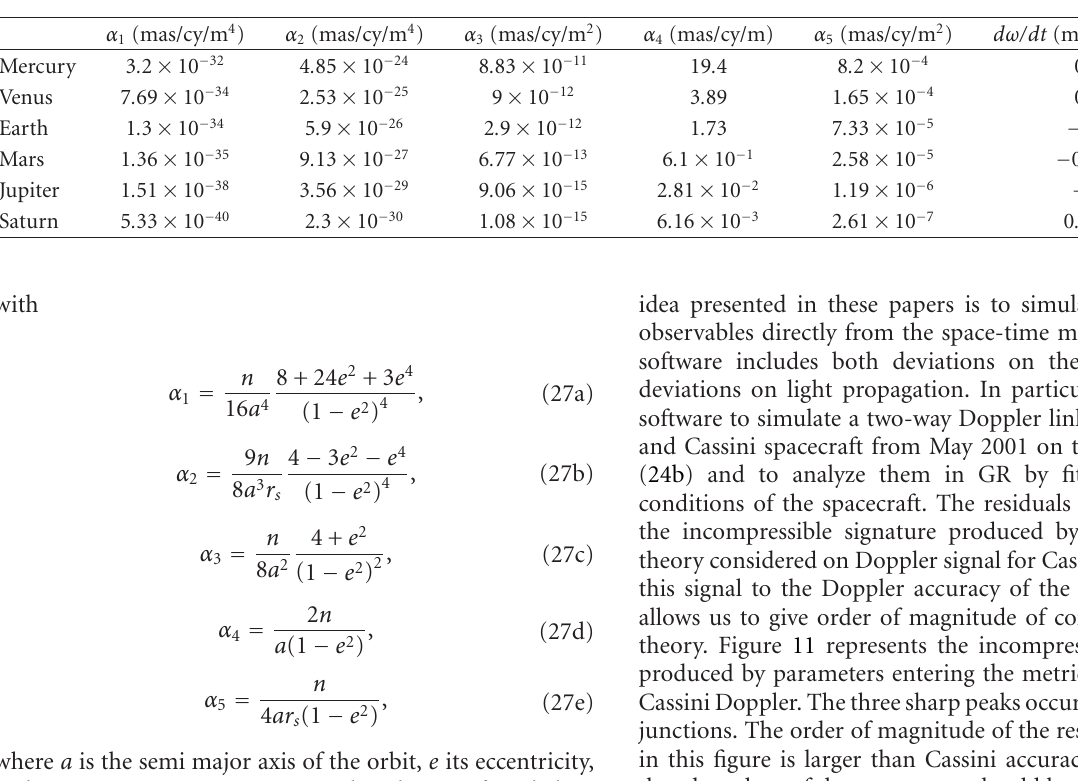
Table 1: Values of the di ff erent α i coe ff cients (27a)–(27e) for planets and constraints given by INPOP10a for supplementary advances of perihelia (values given in